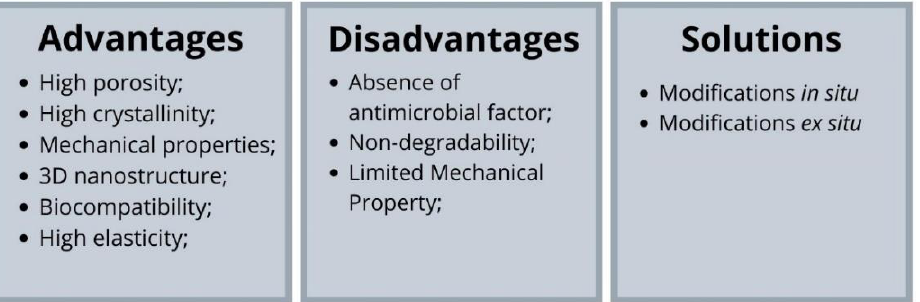
Figure 4. Advantages and disadvantages of bacterial cellulose and solutions to improve its proper-